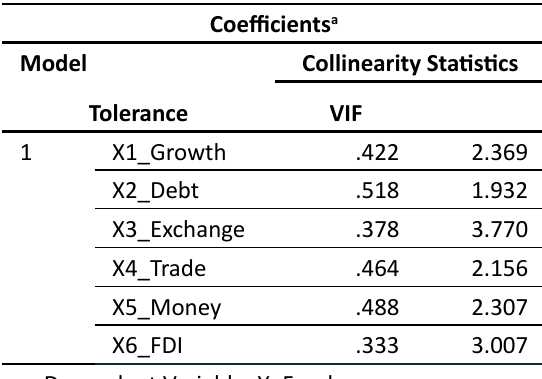
Table 5: Multicolinearity Test Result